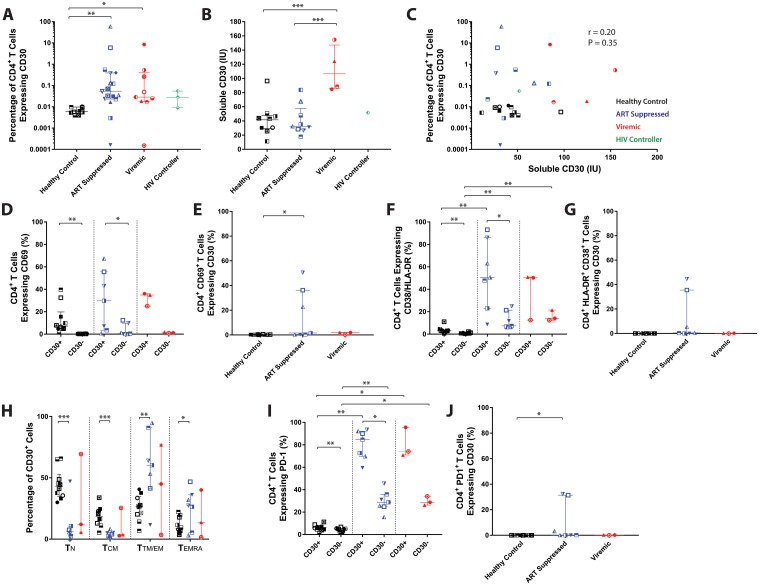
Assessment of CD30 expression on CD4+ T cells.(A) Percentage of CD4+ T cells expressing CD30 in samples from HIV-1-uninfected (n = 10) ART suppressed (n = 17) and viremic donors (n = 9) are shown. Surface expression was higher in ART suppressed and viremic HIV-1-infected individuals (p = 0.0023 and p = 0.045 respectively). (B) sCD30 (IU) in plasma was highest in viremic (n = 4) compared with HIV-1-uninfected (n = 10) and ART suppressed donors (n = 9) (p<0.001 and p<0.001 respectively). (C) No significant correlations were identified between the percentage of CD4+CD30+ T cells and sCD30 levels (r = 0.20, P = 0.35 by Spearman rank correlation analysis). The percentage of CD4+ T cells co-expressing CD69 in each cohort are shown in (D) and the percentage of CD69+CD4+ T cells expressing CD30 are shown in (E). The percentage of CD4+ T cells co-expressing HLA-DR (F) and HLA-DR+CD4+ T cells expressing CD30 (G) are shown. Despite significant increases in CD30+ cells expressing CD38/HLA-DR, there were no significant differences in the frequency of CD30 expression in CD38/HLA-DR-expressing CD4+ T cell populations. (H) The highest frequency of CD30+ T cells observed in HIV-1-infected individuals were of transitional/effector memory phenotype, compared to naïve T cells in healthy controls. (I) CD30+CD4+ and CD30-CD4+ T cells from viremic donors expressed significantly more PD1 than healthy controls (p = 0.02 and p = 0.02 respectively), CD30+CD4+ and CD30-CD4+ T cells from ART suppressed donors also expressed significantly more PD1 than healthy controls (p = 0.002 and p = 0.002 respectively). (J) Conversely, very few CD4+PD1+ T cells co-expressed CD30, but ART suppressed donors had significantly higher expression compared to healthy controls (p = 0.01). T Bars represent median ± interquartile range for all data. *p<0.05; **P < 0.01; ***P < 0.001. Significant intergroup differences were determined using rank Kurskal-Wallis tests incorporating Dunn's tests for multiple comparisons. Wilcoxon matched-pairs signed rank tests were used to determine statistical significant between CD30 intergroup, paired samples.